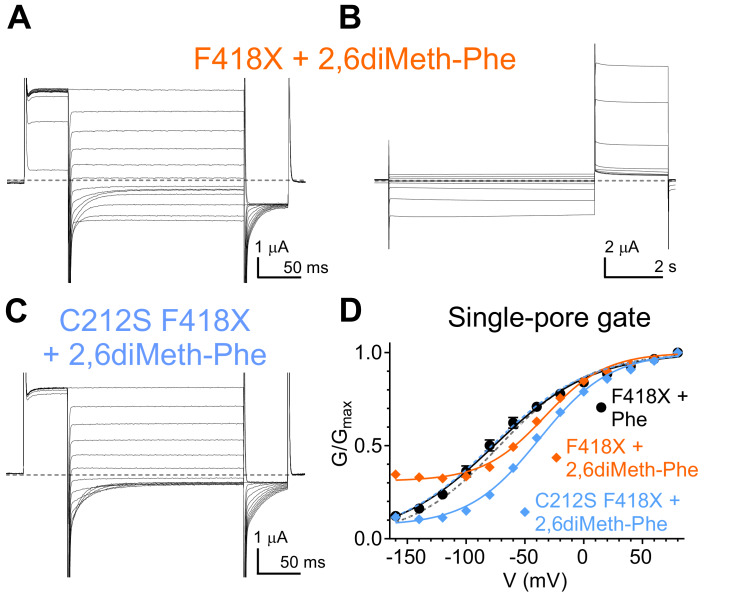
Effects of CLC-0 F418-2,6diMeth-Phe on single- and common-pore gating processes.(A–B) Representative TEVC currents of F418X+2,6diMeth-Phe evoked with single- (A) and common-pore (B) gating protocols, respectively. (C) Representative TEVC currents of C212S F418X+2,6diMeth-Phe evoked with the single-pore gating protocol. (D) Normalized G-V relationships of the single-pore gating processes of F418X+Phe (black circles; from Figure 7), F418X+2,6diMeth-Phe (orange diamonds) and C212S F418X+2,6diMeth-Phe (cyan diamonds; from Figure 7). Solid lines represent fits to a Boltzmann function with an offset (see Materials and methods, Equation 1). WT G-V curves (from Figure 6) are shown as gray dashed line for reference and C212S F418X+Phe G-V as cyan dashed line. Values are reported as mean ± S.E.M, error bars are not shown where they are smaller than the symbol size. Values for the fit parameters and number of repeats are reported in Supplementary file 1. The raw data for the traces shown is available in Figure 7—figure supplement 2—source data 1.Figure 7—figure supplement 2—source data 1.Individual data points.